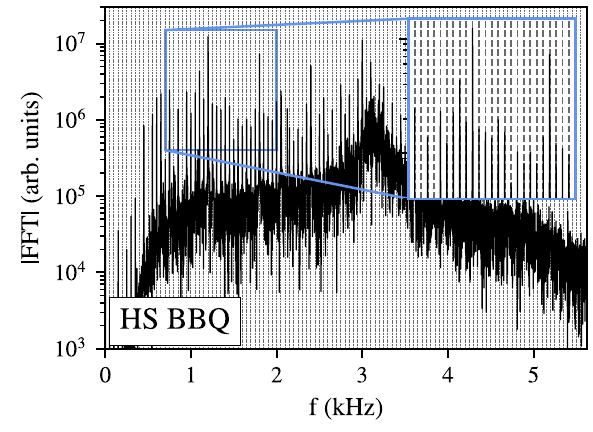
FIG. 3. The horizontal spectrum of Beam 1 at injection energy during the MD Fill 7343 from the HS BBQ and with a zoomed window (light blue). The vertical gray lines represent the multi- ples of 50